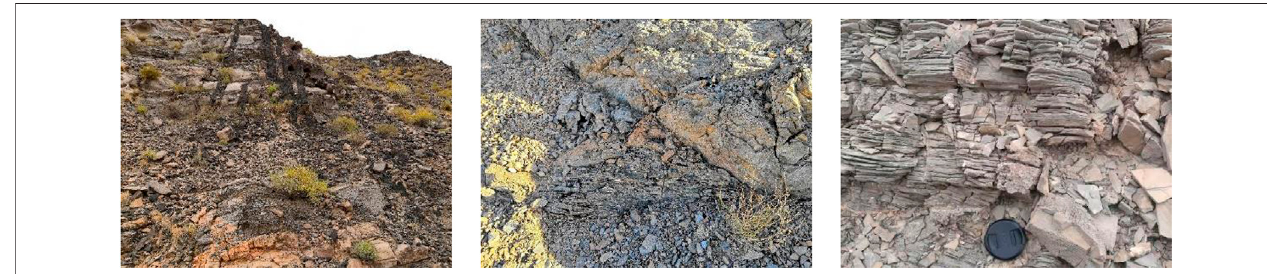
FIGURE 2 | Typical fractured rock mass in the study area.